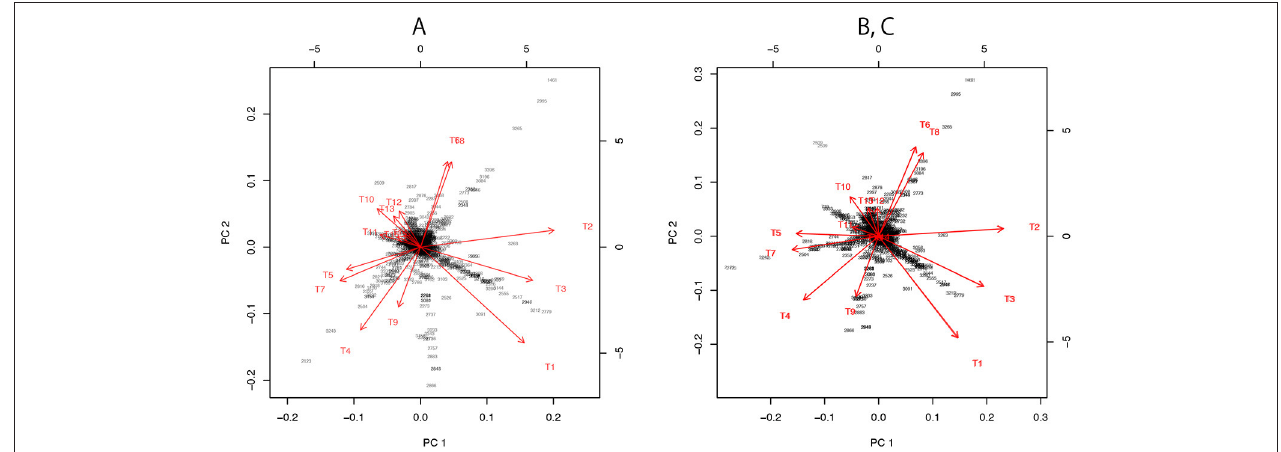
FIGURE 7 | Three versions the visualization of probability distributions for the best 15 trees drawn using different sets of models. (A) Only the 15 bifurcating trees. (B) 15 bifurcating trees + 10 partially resolved trees + 1 star topology. This is the same plot as Figure 3B . (C) 15 bifurcating trees + 1 star topology. Note that (B,C) are superimposed, since their plots are almost